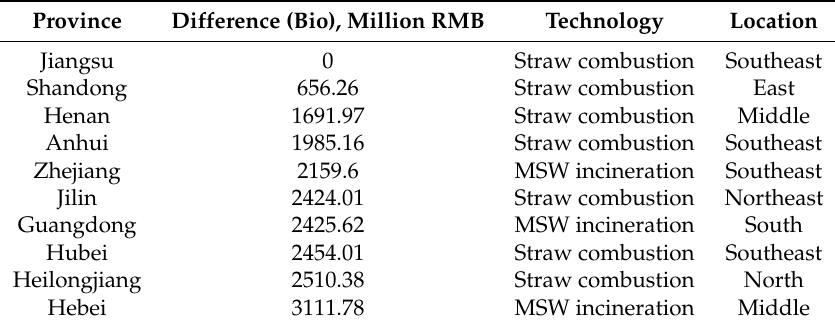
Table 5. Ten most efficient provinces ranked in regards to the gap between the observed profit and maximum profit in biomass